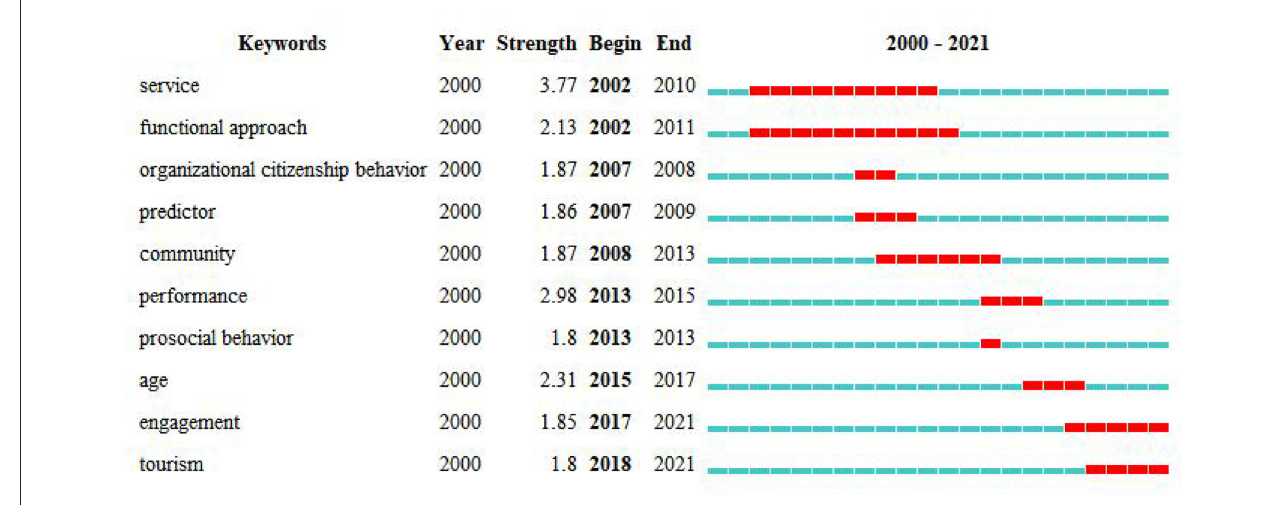
FIGURE 6 | Top 10 keywords with the strongest citation bursts.